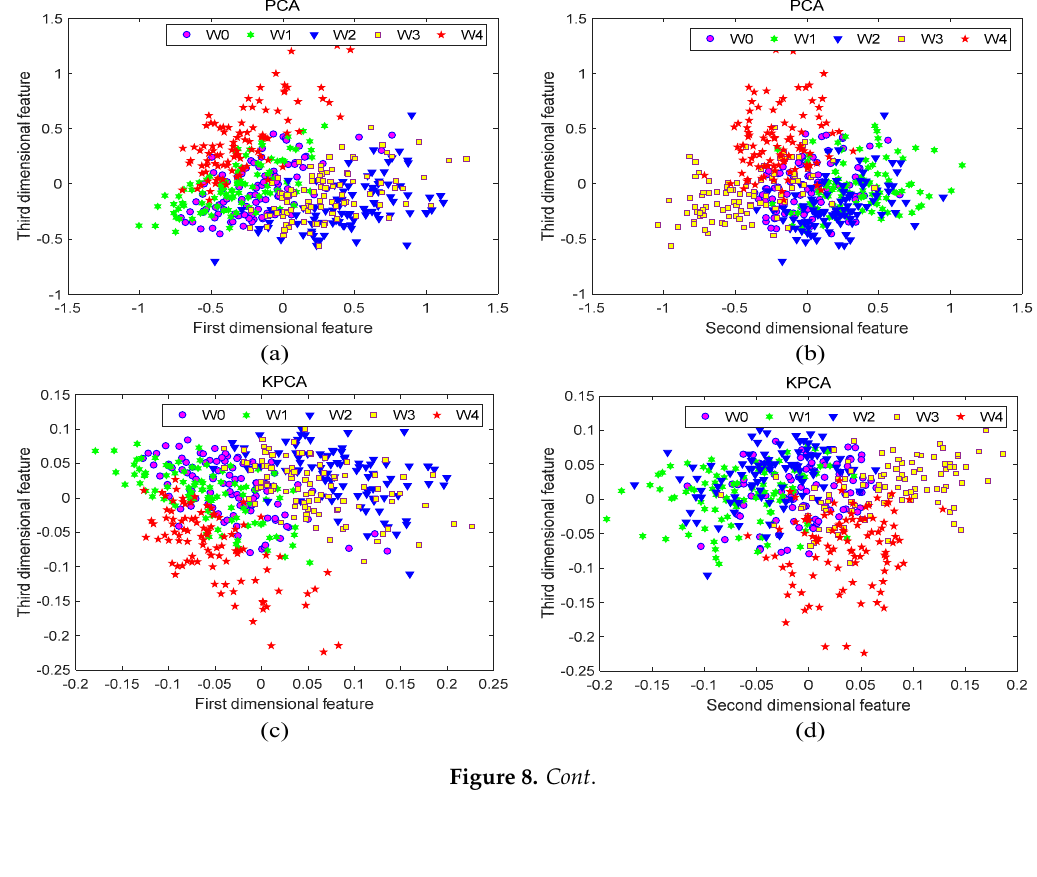
Figure 8. Dimensional reduction effects of other dimensions for Principal Component Analysis (PCA), Kernel Principal Component Analysis (KPCA), and Locally Linear Embedding (LLE): ( a ) The first and the third dimensional features of PCA; ( b ) The second and the third dimensional features of PCA; ( c ) The first and the third dimensional features of KPCA; ( d ) The second and the third dimensional features of KPCA; ( e ) The first and the third dimensional features of LLE; ( f ) The second and the third dimensional features of LLE. 4.3. Results and Analysis Prior to the specific fault assessment, the misfire fault categories were distinguished by different labels, as shown in Table 5. The whole tests were divided into four groups. Each working condition group contains five types of working conditions. Specifically, the test numbers 1–5, 6–10, 11–15, and 16–20 of Table 1 belonged to the working condition groups I, II, III, and IV, respectively. The